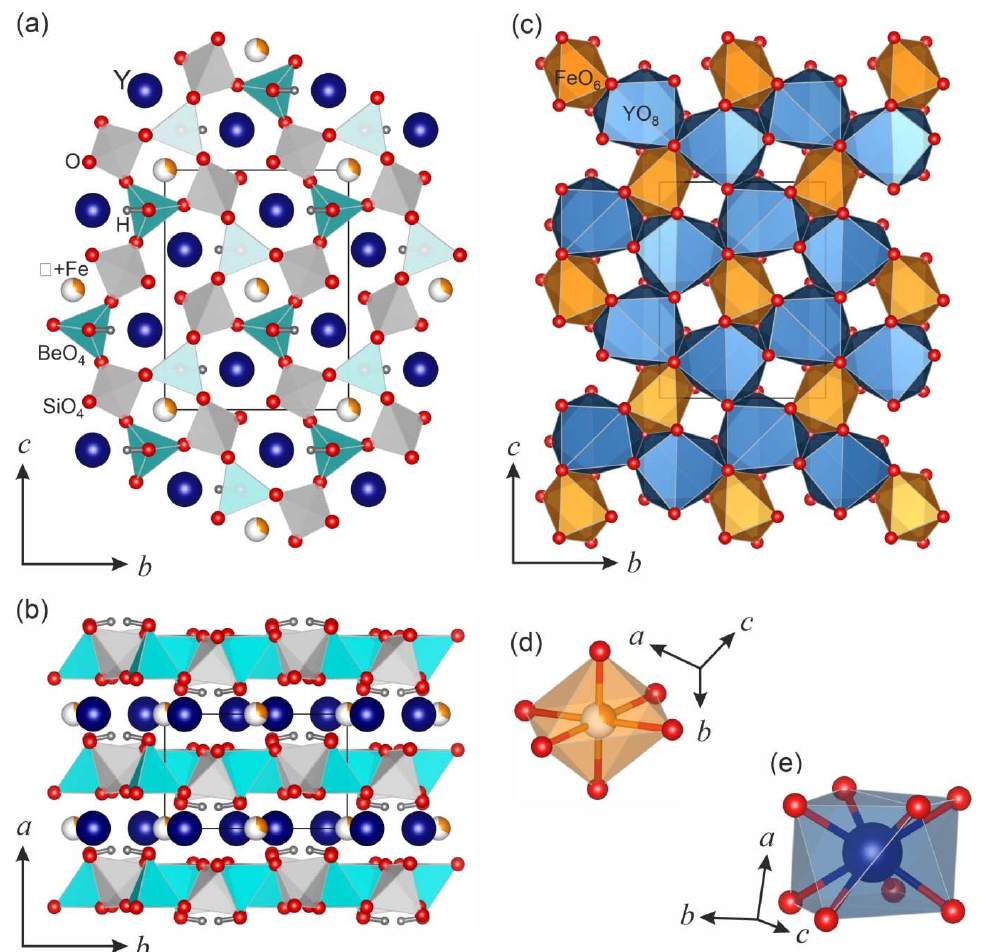
Figure 6. Crystal structure of hingganite ‐ (Y): ( a ) in the cb plane, ( b ) in the ab plane; ( c ) large cations layer in cb plane; ( d ) FeO 6 in a ball ‐ and ‐ stick representation, (e) YO 8 polyhedra in a ball ‐ and ‐ stick representation. BeO 4 and SiO 4 tetrahedra are given in light blue and grey, respectively; Y and H atoms are shown as dark blue and grey spheres, respectively; vacancy and Fe 2+ in the M site demonstrated as a percentage by white and orange, respectively.